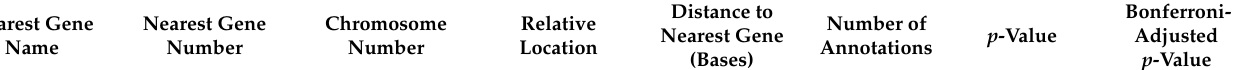
Table 4. Cannabis Impacts on Centrosomal Proteins, Schrott EWAS